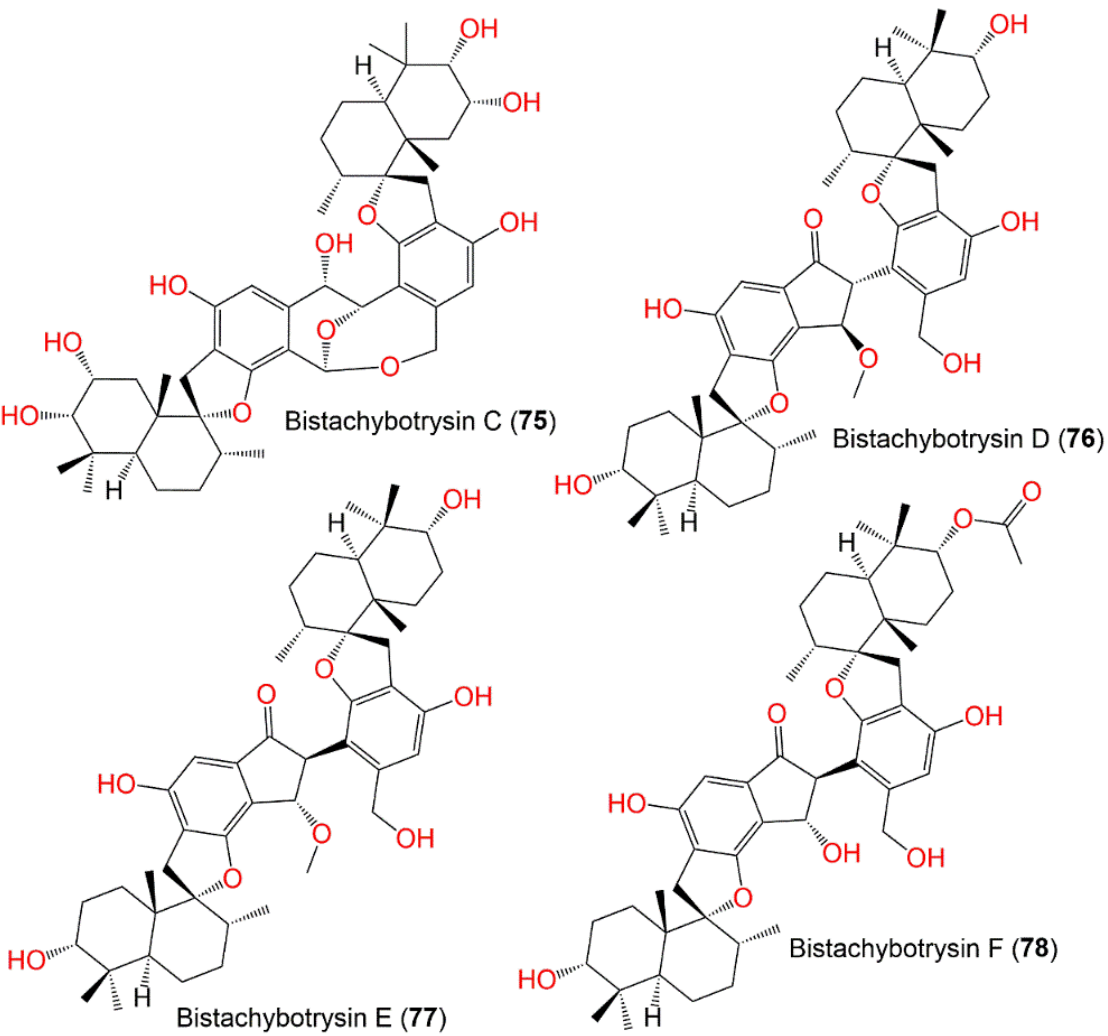
Figure 8. Structures of dimeric phenylspirodrimane derivatives ( 75 – 78 ) reported from S . chartarum . Further investigation is worth pursuing for 73 and 74 as new promising antitumor lead compounds [79]. They were postulated to be originated from farnesyl-diphosphate and orsellinic acid that give phenylspirodrimane monomer (Scheme 4). Then, a pinacol coupling reaction among the two CHO groups of 3 and 2 gives a vicinal-diol intermediate I . After that, one OH group of the 22,23‘-diol moiety fuses further with the other CHO of 2 to produce II with a six-membered oxygen heterocyclic ring through acetalization intermolec- ularly. Subsequently, the dehydration of the mer-NF5003E ( 3 ) CH 2 OH and hemiacetal OH groups yields 73 through 6/7 oxygen heterocyclic linkage. Further, 74 is resulted from bistachybotrysin A by selective acetylation, whereas 75 is generated from 5 and 2 through pinacol-coupling reaction, intermolecular acetalization, and dehydration [79]. Bistachybotrysins D ( 76 ) and E ( 77 ), stereoisomeric phenylspirodrimane dimers, have a central [6,5,6]-tricyclic carbon skeleton involving a cyclopentanone ring. Their struc- tures were verified by extensive spectral analysis, and their configurations were estab- lished by ECD. Compound 76 demonstrated [6,5,6]-tricyclic carbon scaffold that dimerized through 3-(hydroxymethyl)cyclopentanone core C-C connected to one phenyl ring and fused to the other. Compound 77 has the same structure as 76 with 23S/23’S instead of 23R/23 (cid:48) R in 76 . These metabolites (IC 50 ranged from 6.7 to 11.6 µ M) had pronounced cytotoxic potential versus Daoy, HCT116, BGC823, and HepG2 cell lines. Besides, 76 possessed neural anti-inflammatory potential by prohibiting NO production in BV2